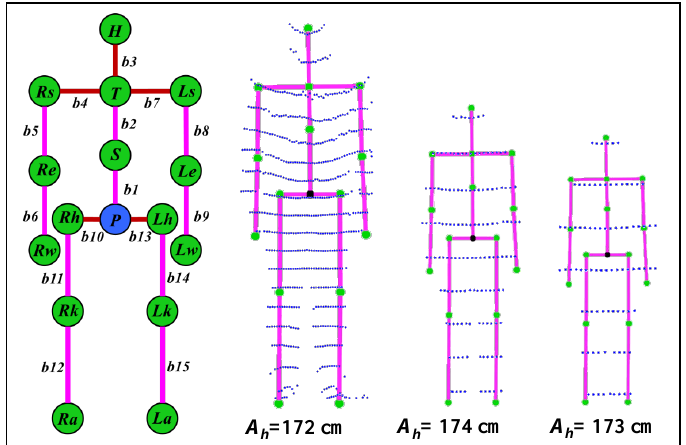
Figure 4. Actual height estimation and skeleton construction at different distances.